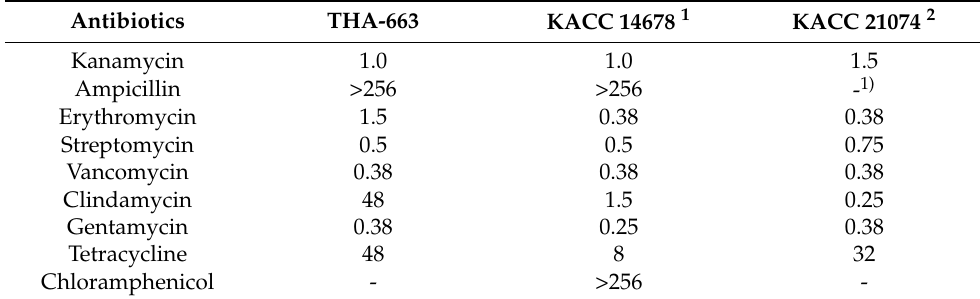
Table 2. Minimum inhibitory concentration (MIC) for antibiotics.